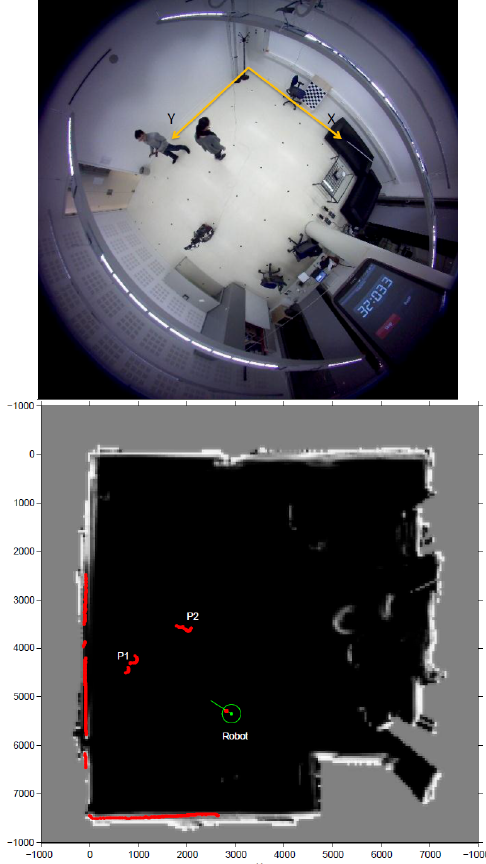
Figure 8. An overview of data that are used in our data fusion system. The top graph shows an image frame captured by the overhead camera, where the yellow arrows indicate the direction of X and Y axis in the world coordinate system. The bottom graph shows a pre-computed probabilistic background map of the same area (in grey scale). The green circular marker indicates the location and the orientation of the robot. The red dots are the laser detection points in world coordi- nates. We show that the two persons (P1 and P2) in the camera image are also detected by the laser scanner. In our system, the two data source are fused to jointly estimate human locations.